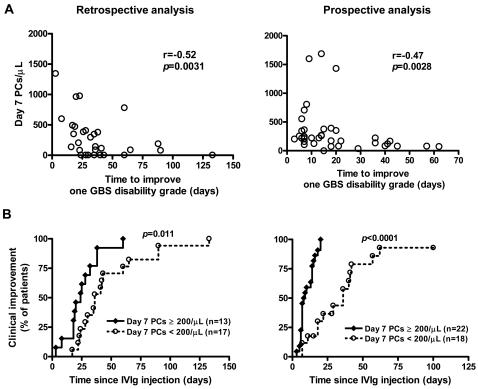
Correlation between the number of plasma cells and clinical improvement in retrospective (n = 30, left panels) and prospective (n = 40, right panels) studies.(A) Strong negative correlation in both studies between the absolute number of IVIg-mobilized plasma cells (PCs) and time to improve one GBS disability-grade. Correlation was analyzed using Spearman test. (B) Day 7 plasmacytosis correlates with faster clinical improvement. Kaplan-Meier analysis of time to one disability-grade improvement following IVIg in relation to day 7 plasma cell counts enumerated on a routine hematology analyzer and confirmed by blood smear exam.